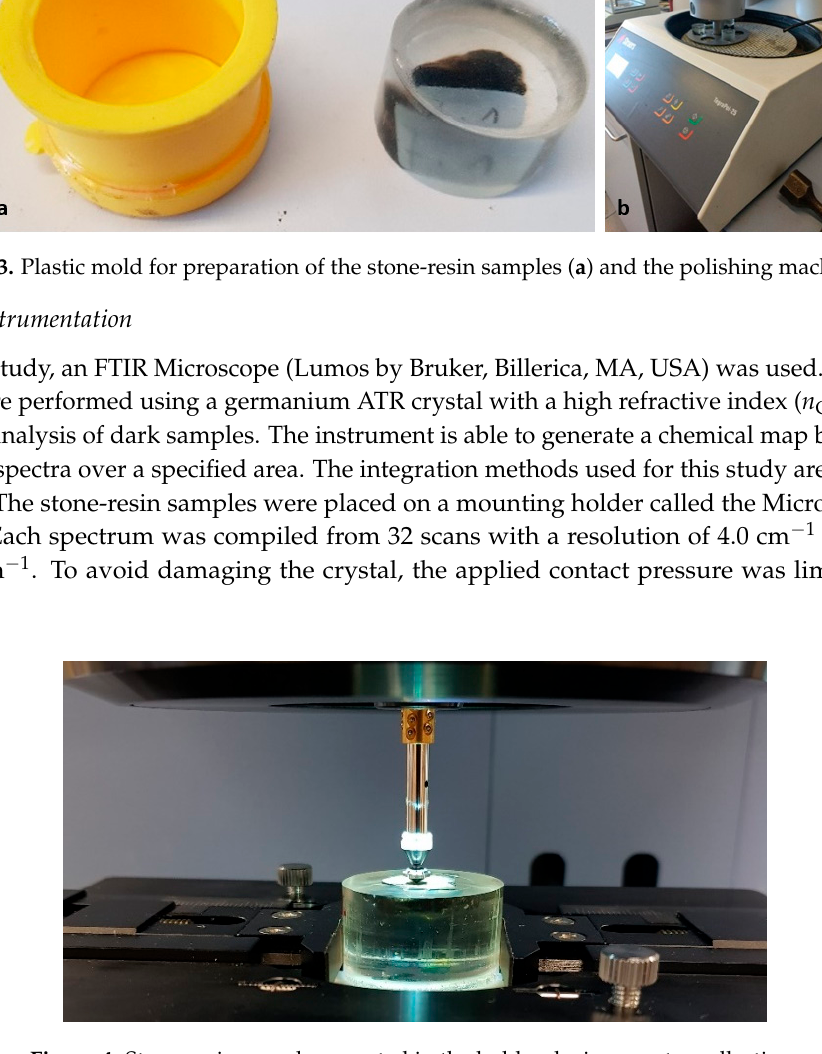
Figure 4. Stone-resin sample mounted in the holder during spectra collection.